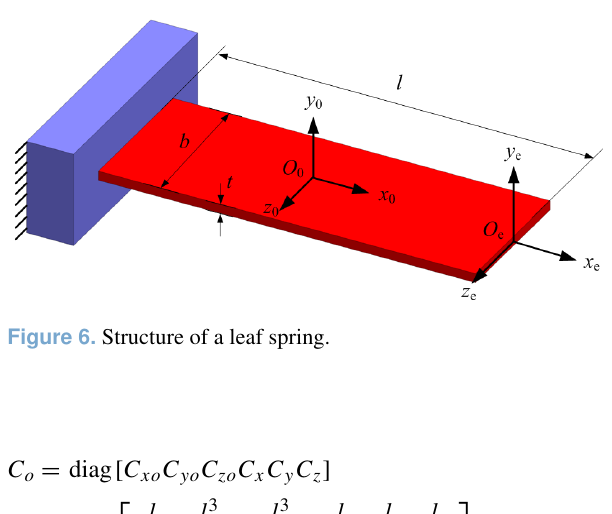
Figure 5. Side view of a leaf-spring set.